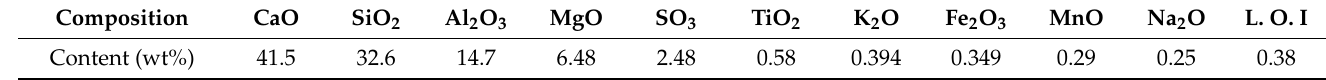
Table 1. Chemical components of the BFS (mass